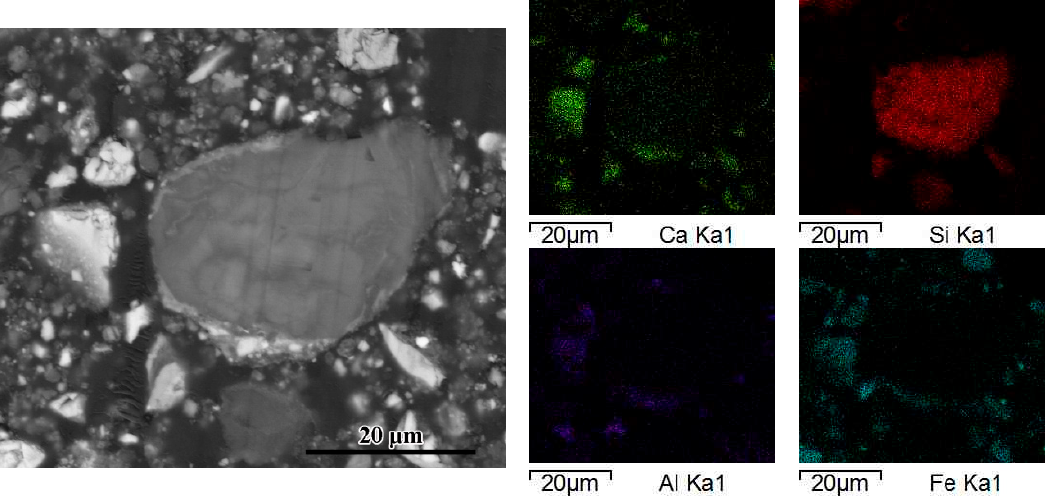
Figure 5. Element mapping of typical leached slag with 540 W microwave (10 min).